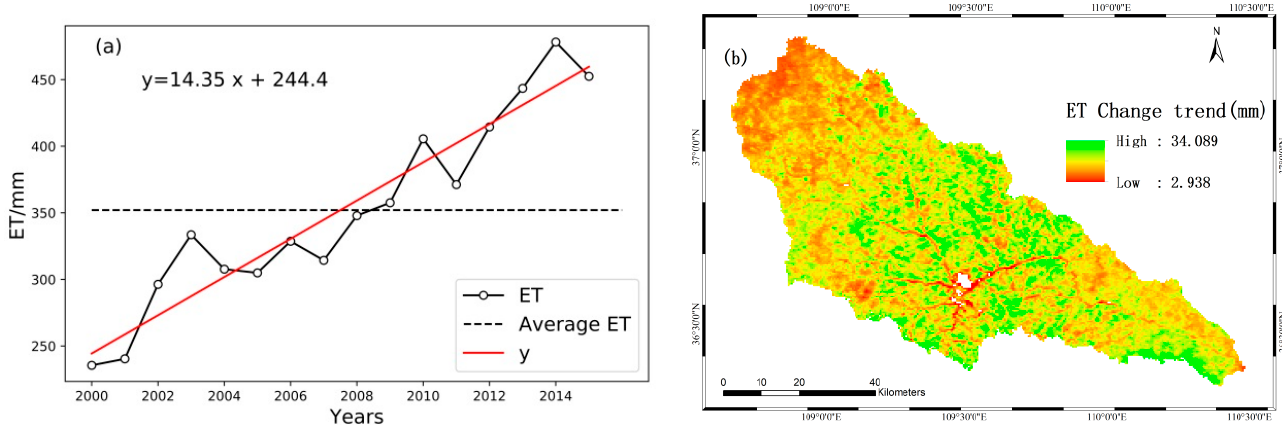
Figure 5. ET in the YanHe Watershed from 2000–2015: ( a ) Annual average ET time series; ( b ) Change trend map of ET (significance level 95%).